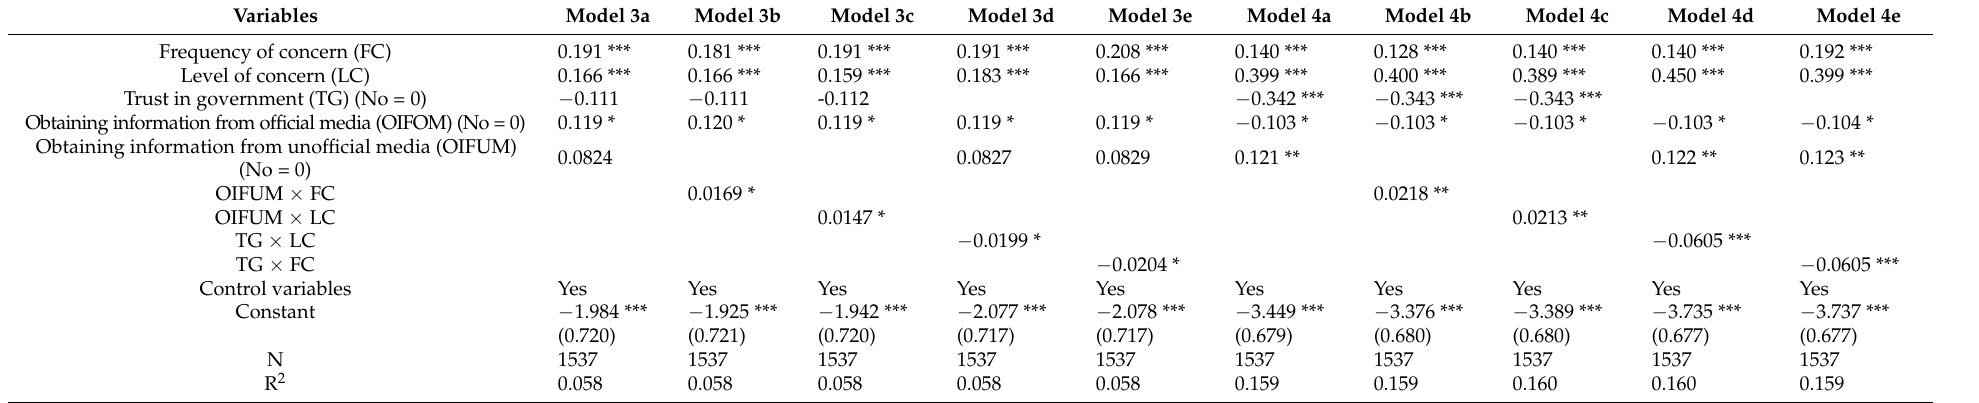
Table 5. Regression model of trust in government and obtaining information channels (robustness